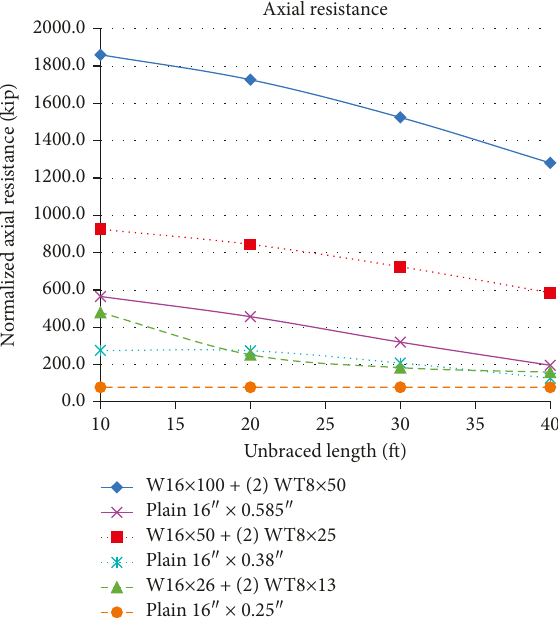
Figure 5: Axial resistance for comparative plain and flanged cruciform members (1ft 0.305m and 1kip (cid:30) (cid:30)